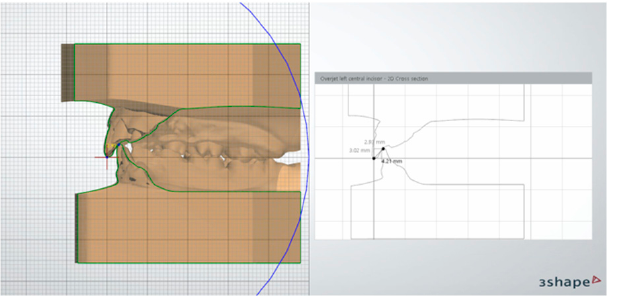
Figure 5. Linear measurements (for example, overjet and overbite) were made on digital models using 3Shape Ortho Analyzer ™ software (3Shape A/S • Holmens Kanal 7, 4. 1060 Copenhagen, Denmark). Table 1. Angular cephalometric values measured on the teleradiography of the skull in a lateral- lateral projection.